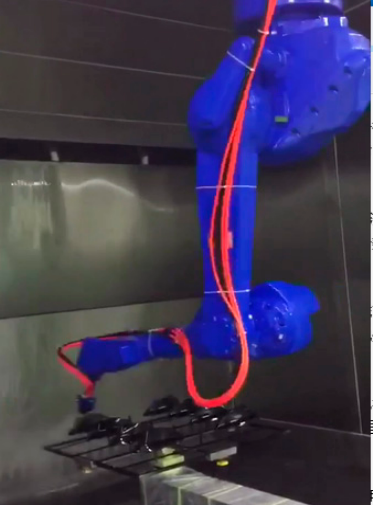
Figure 9. Spraying robot.